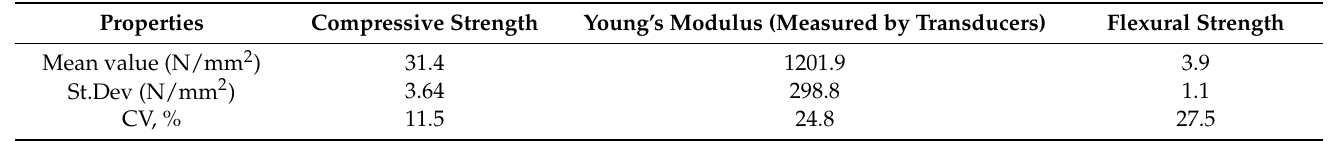
Table 2. Material properties of